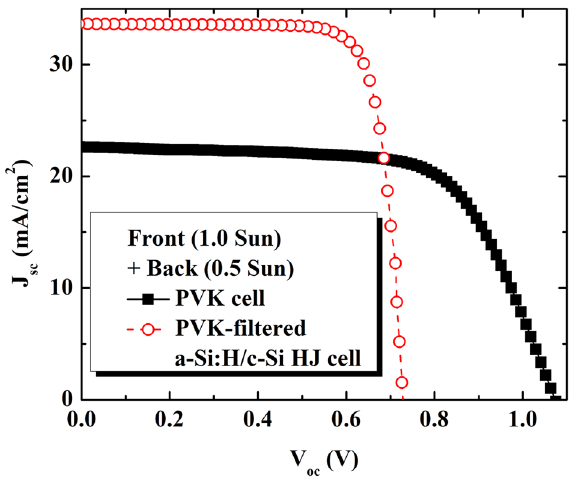
Figure 7. Representative J–V curves of the PVK top sub-cell and PVK-filtered a-Si:H/c-Si HJ bottom sub-cell in a bifacial 4-terminal PVK/c-Si HJ tandem solar cell under 1.0 sun (front-side) and 0.5 sun (back-side).